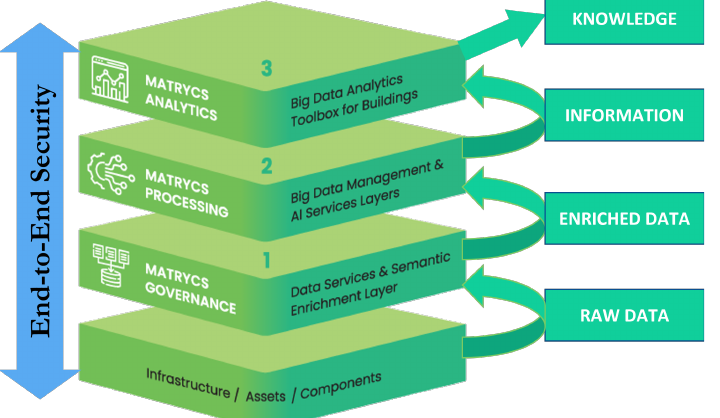
Figure 3. High-level view of the MATRYCS architecture layers and of their association to each transformation step of the data value